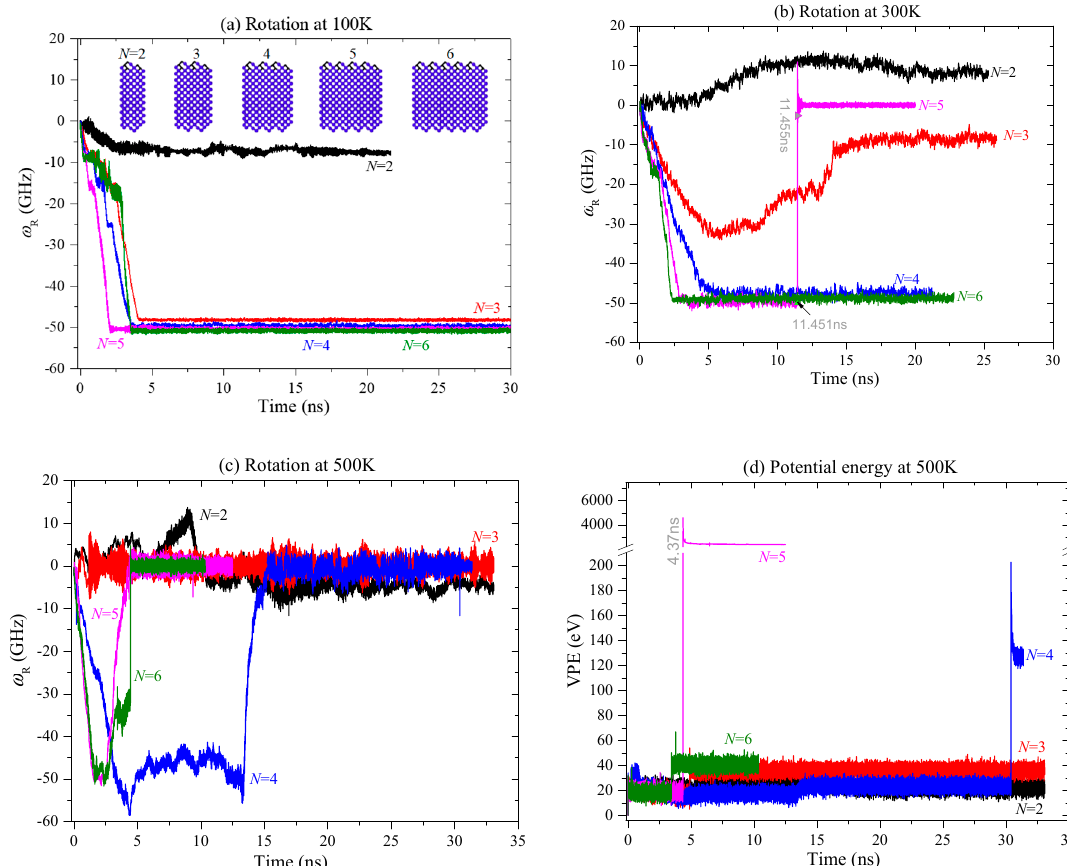
Figure 2. Histories of rotor rotation at different conditions. ( a ) The rotational frequency of rotor driven by different DNs at 100 K, ( b ) at 300 K, and ( c ) at 500 K. ( d ) Variation of potential energy (VPE) of the system at 500 K.